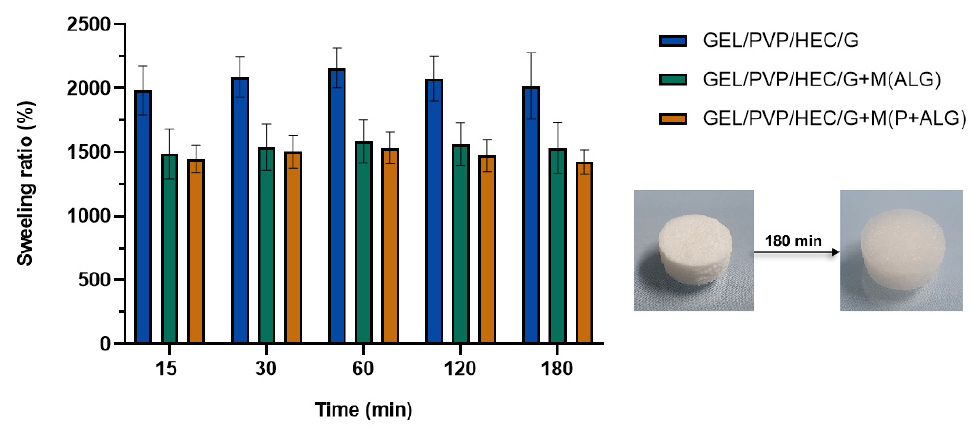
Figure 5. Swelling percentage of GEL/PVP/HEC/G matrices with incorporated microparticles.